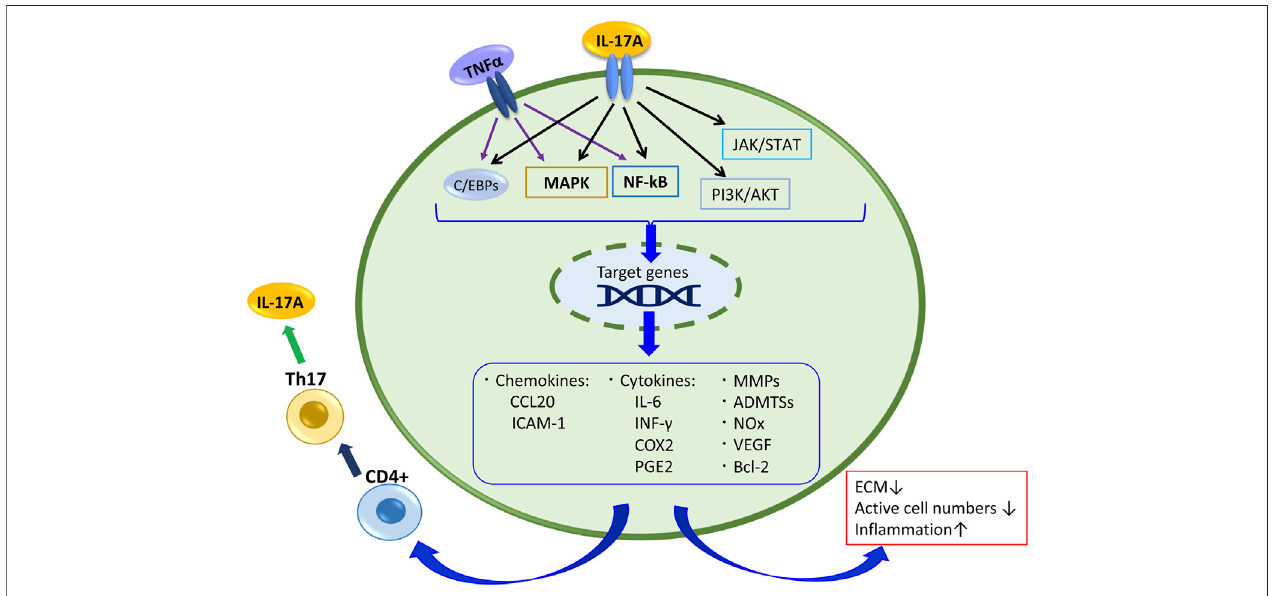
FIGURE2| IL-17Asignalingand its related products indisccelland tissue.Also,TNF α stimulates theNF-kB andMAPKpathwaysand C/EBPs, and contributes to the production of cytokines, chemokines, and extracellular matrix-degrading factors in IVD.